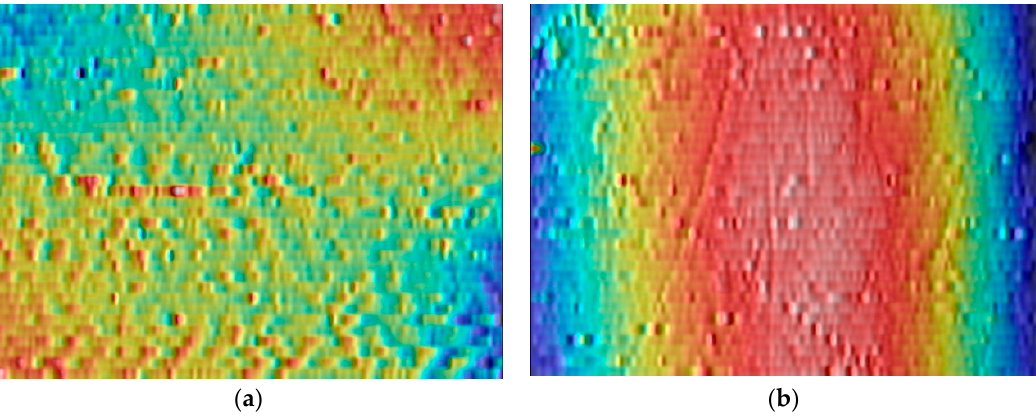
Figure 19. Typical surface morphology within non-necked area (140 × 100 μ m). ( a ) 30% strained; ( b ) 100% strained.